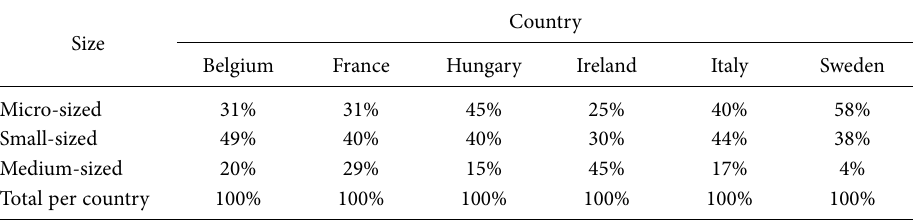
Table 1. Distribution of SMEs in European